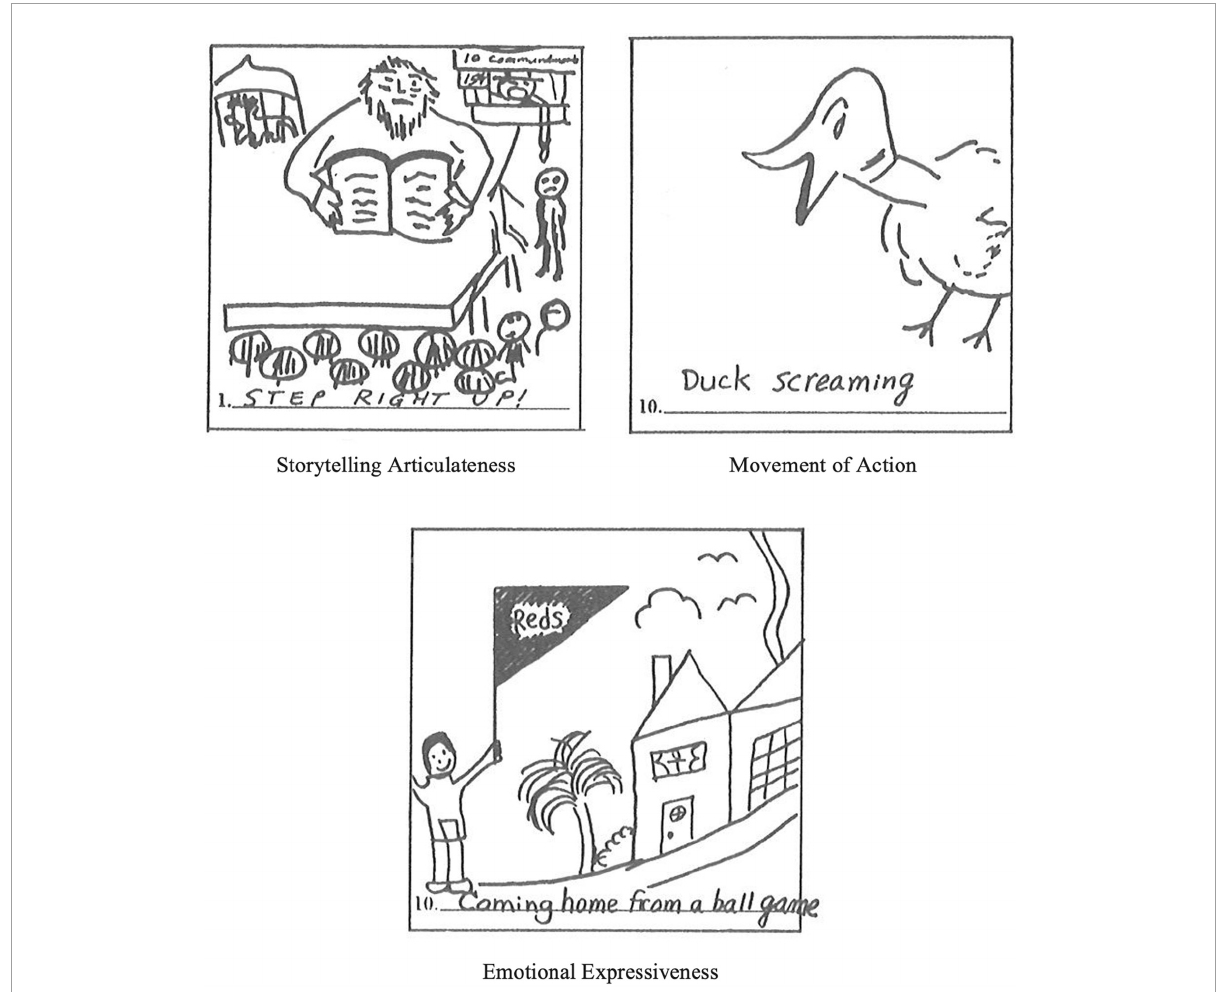
FIGURE4 Example of responses on three creative strengths